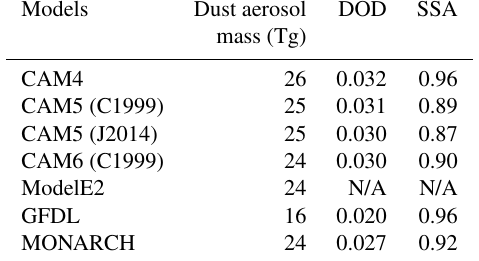
Table 3. DOD and dust burdens (Tg) in CAM4, CAM5 with C1999 and J2014, CAM6 with C1999 with hematite coming solely from the clay-sized category, and ModelE2 with C1999, GFDL, and MONARCH. Note differences in the global mean dust SSA cal- culation between CAMs and MONARCH: in CAM, the global mean dust SSA was derived from the simulated SSA for total aerosols at the 0.44–0.63µm band by retaining only pixels with DOD > 0.5 · AOD in the calculation following Scanza et al. (2015); in MONARCH, the global mean SSA was calculated based on the simulated SSA at the 0.44–0.63µm band for pure dust aerosol; in GFDL, the global mean SSA was calculated based on the simulated SSA at the 0.50–0.60µm band for pure dust aerosol. Models Dust aerosol DOD SSA mass (Tg)